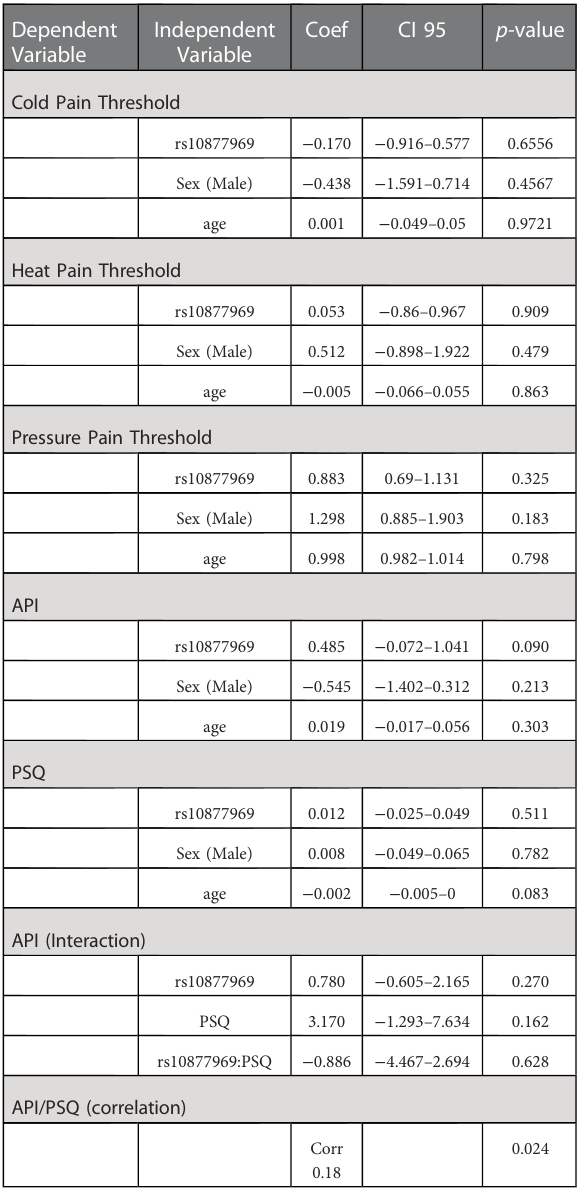
TABLE 3 Experimental and clinical pain associations with rs10877969 adjusting for relevant